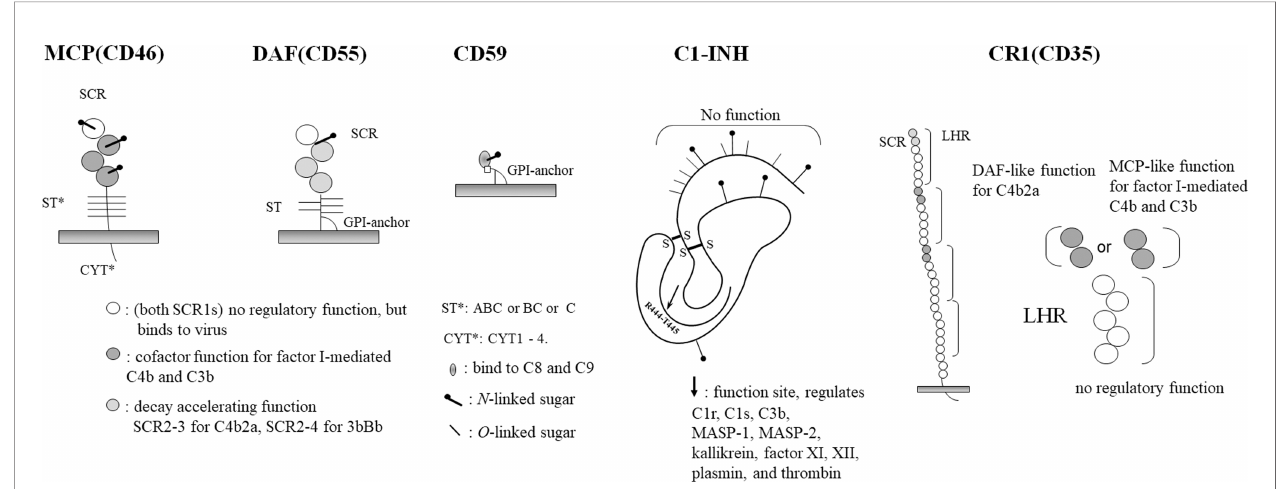
FIGURE 1 | Complement regulatory proteins. A schematic diagram of each complement regulatory proteins, MCP, DAF, CD59, C1-INH and CR1, are